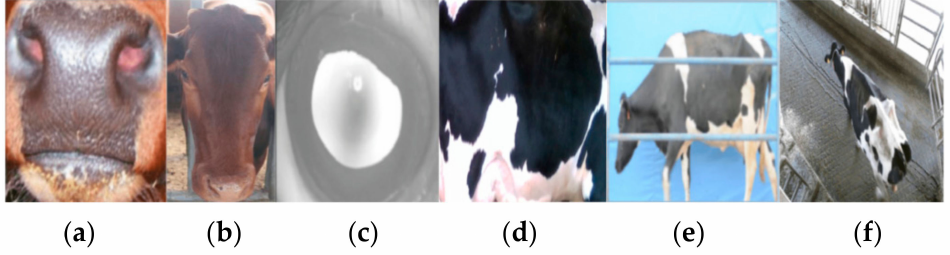
Figure 1. Some research focus for cow identification. ( a ) Muzzle, ( b ) face, ( c ) iris, ( d ) body, ( e ) cow’s side and ( f )